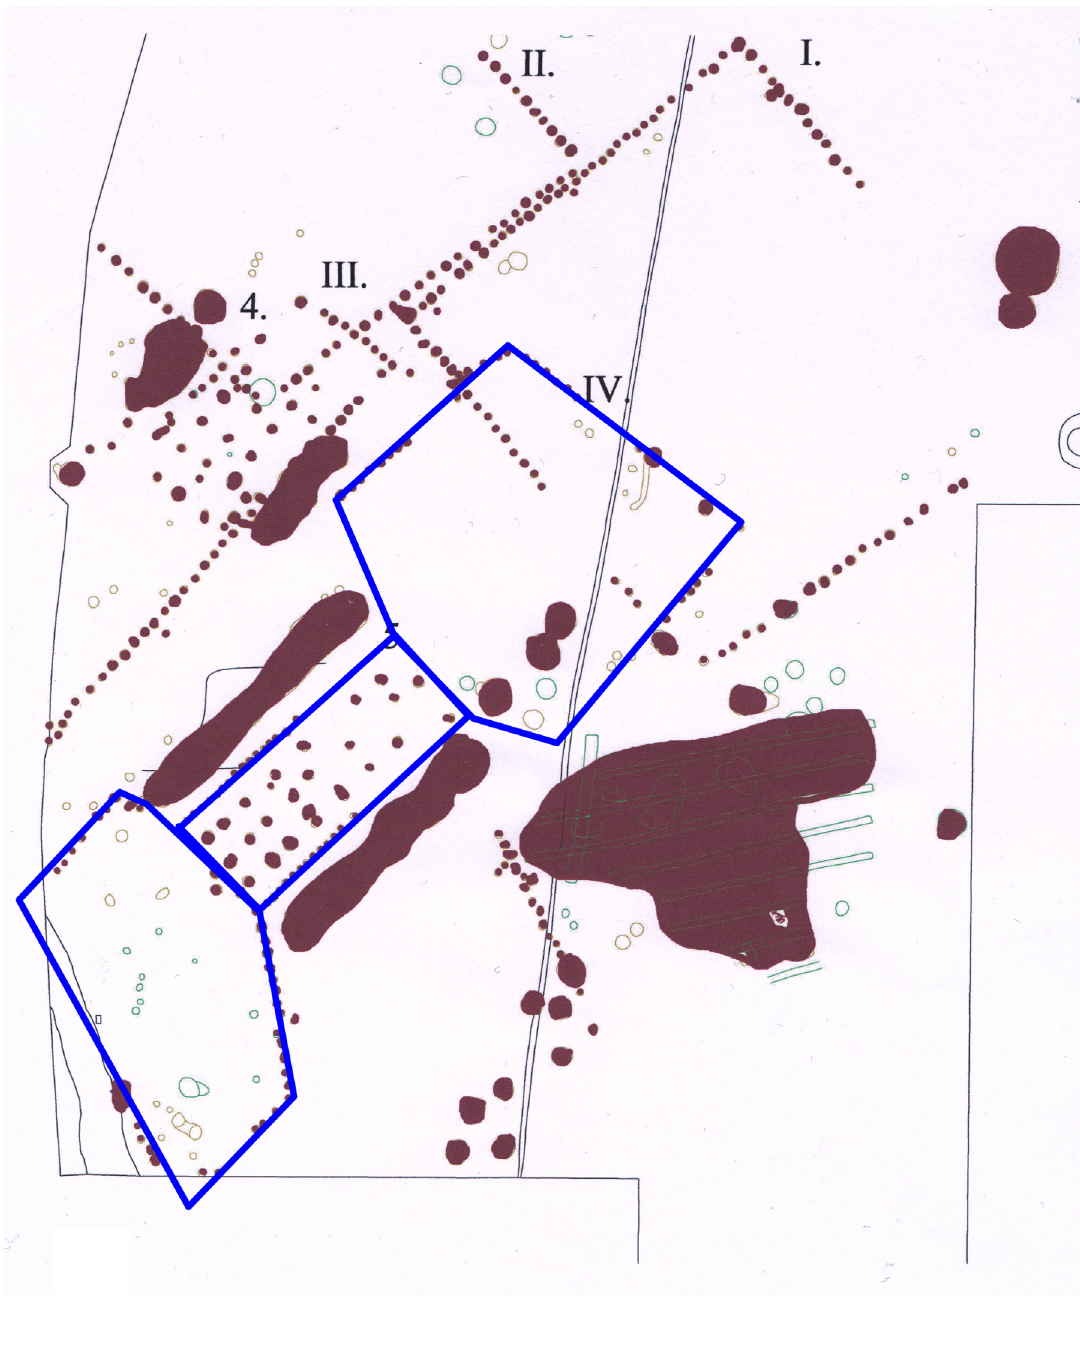
Figure 2: Harta (Hungary). Proposed reconstruction of the Linear Pottery house No.5. After Kustár, Lantos, Hajnalová, Sümegi